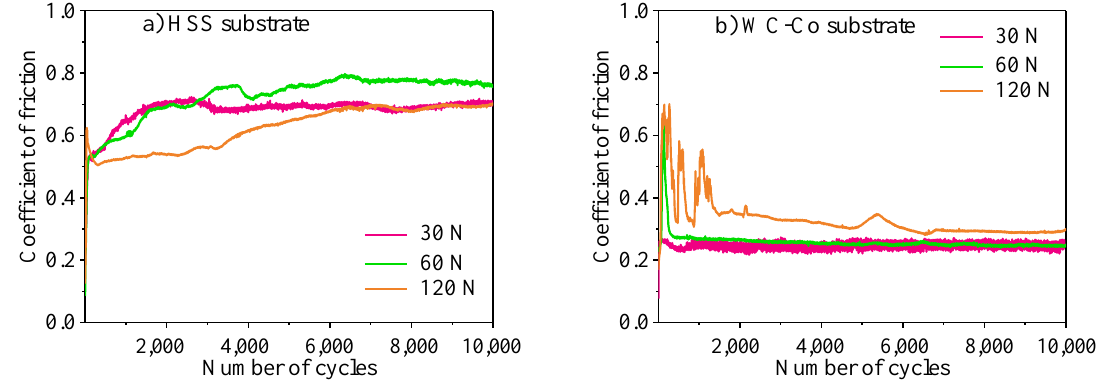
Figure 3. CoFs of uncoated samples as a function of cycle number under various normal forces: ( a ) HSS substrate; ( b ) WC-Co substrate.